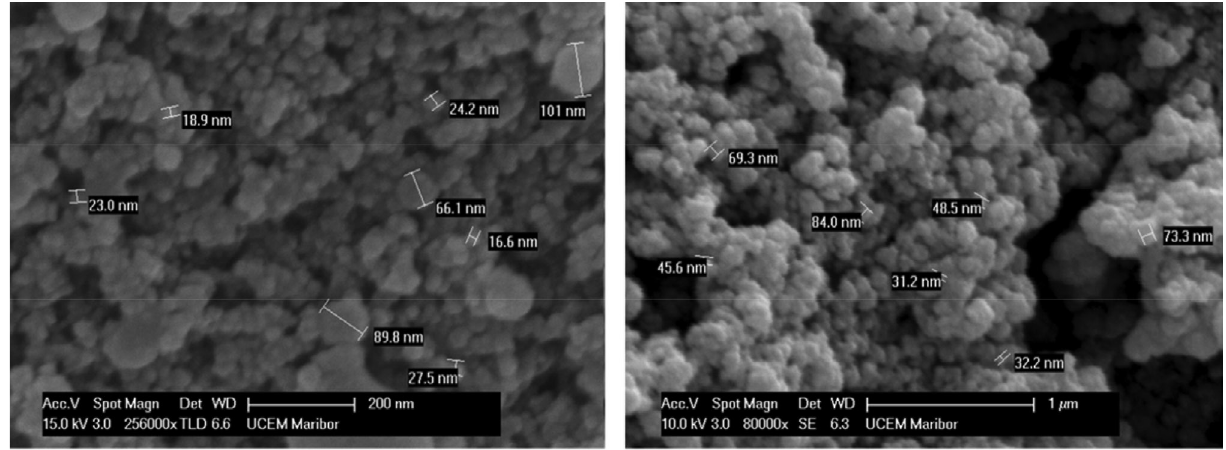
Figure 3 . SEM images of CMD-MNPs (left) and ADH-CMD-MNPs (right).